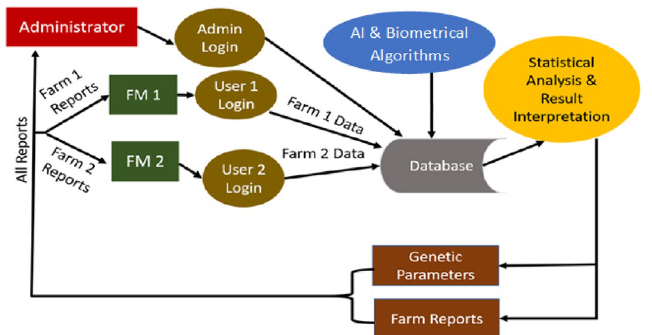
Figure 1. Data flow diagram